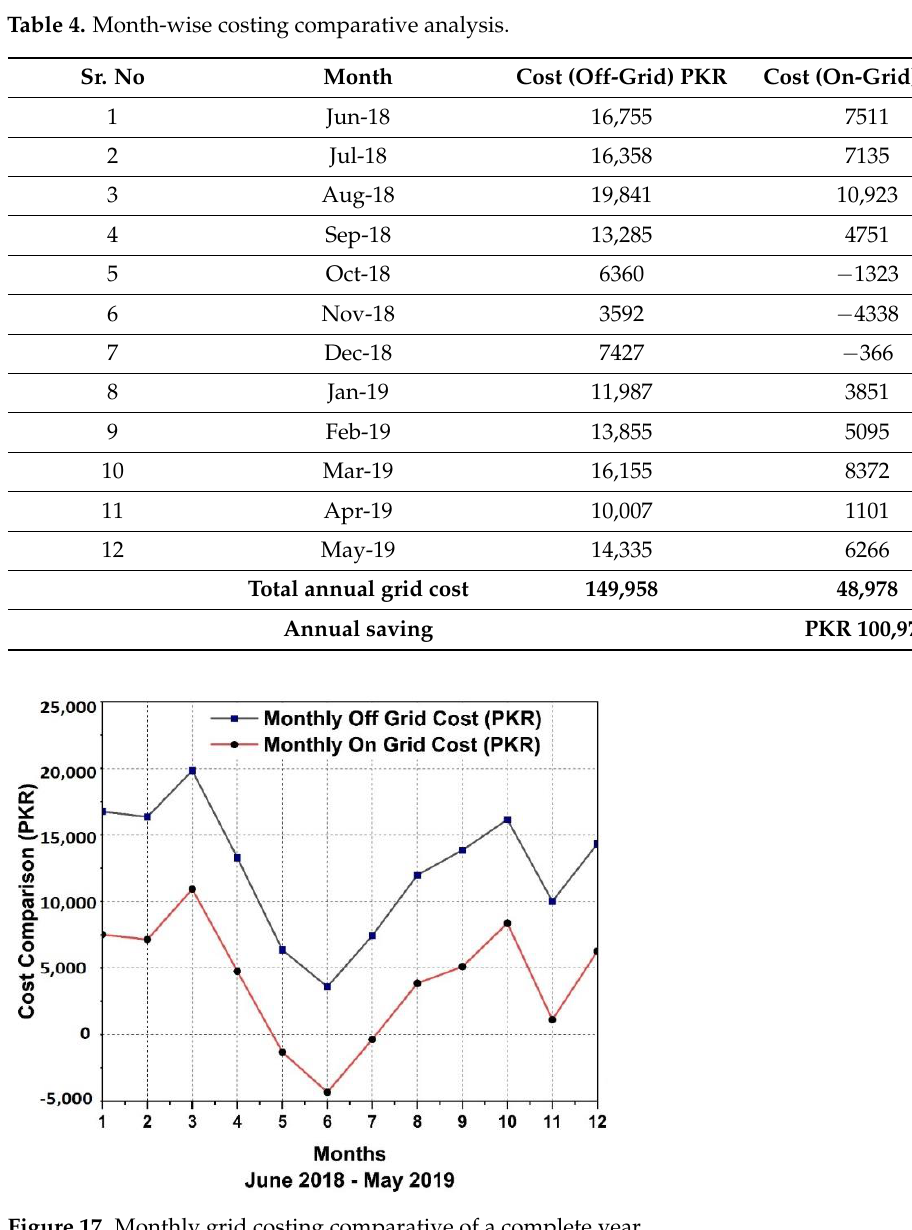
Figure 17. Monthly grid costing comparative of a complete